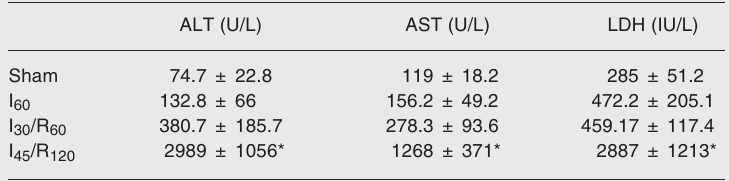
Table 1. Serum ALT, AST and LDH concentrations of mongrel dogs subjected to sham operation, 60 min of ischemia (I 60 ), 30 min of ischemia followed by 60 min of reperfusion(I 30 /R 60 ), and 45 min of ischemia followed by 120 min of reperfusion (I 45 / R 120 ).